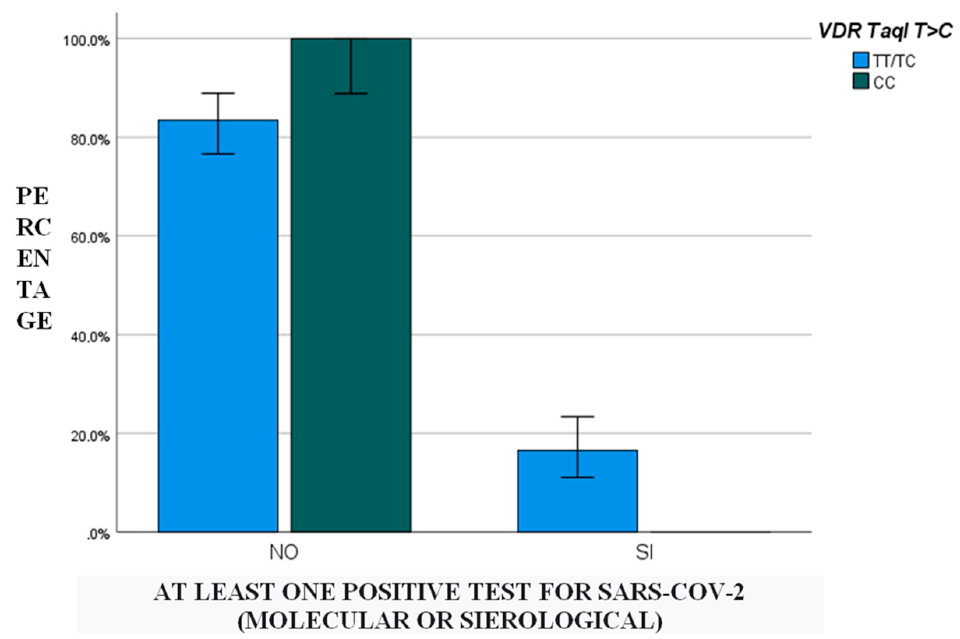
Figure 1. Graph showing that none of the patients with the CC genotype for the VDR TaqI polymorphism (CC) ever tested positive for SARS-CoV-2.